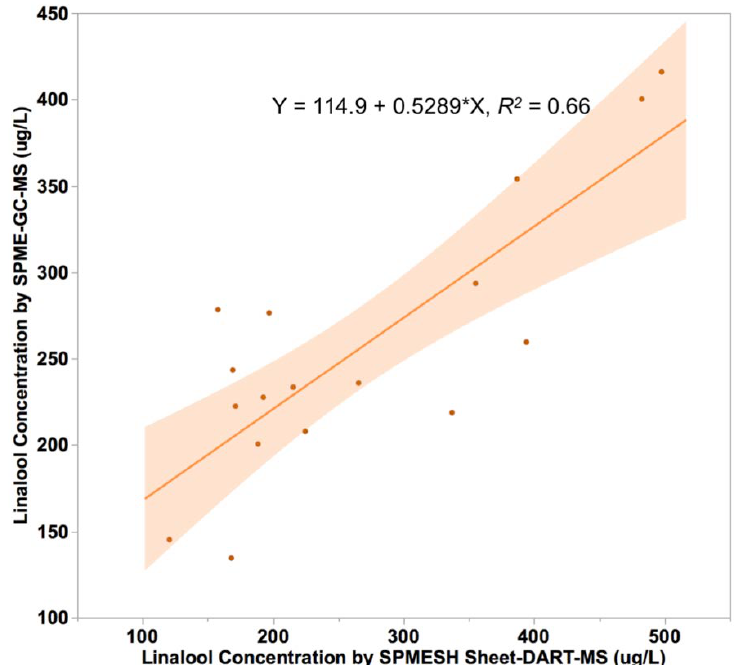
Figure 5. Correlation between linalool equivalents measured by SPMESH sheet-DART-MS, compared to SPME-GC-MS (solid phase microextraction – gas chromatography – mass spectrometry). Shaded area represents the 95% confidence interval of the linear regression.